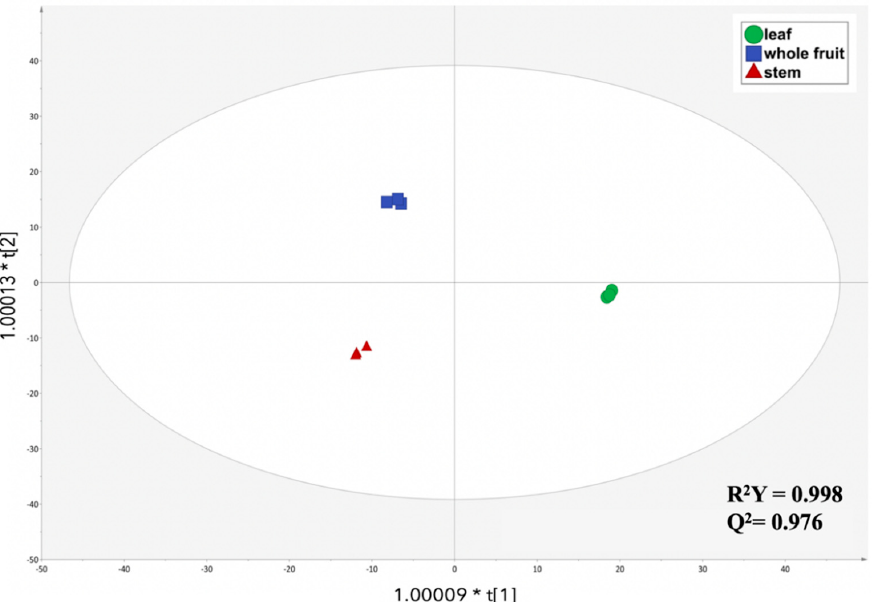
Figure 3. Orthogonal projections to latent structures discriminant analysis (OPLS-DA) score plot built according to phenolic profiling of Cydonia oblonga Mill. and considering the different plant extracts as discrimination parameter.